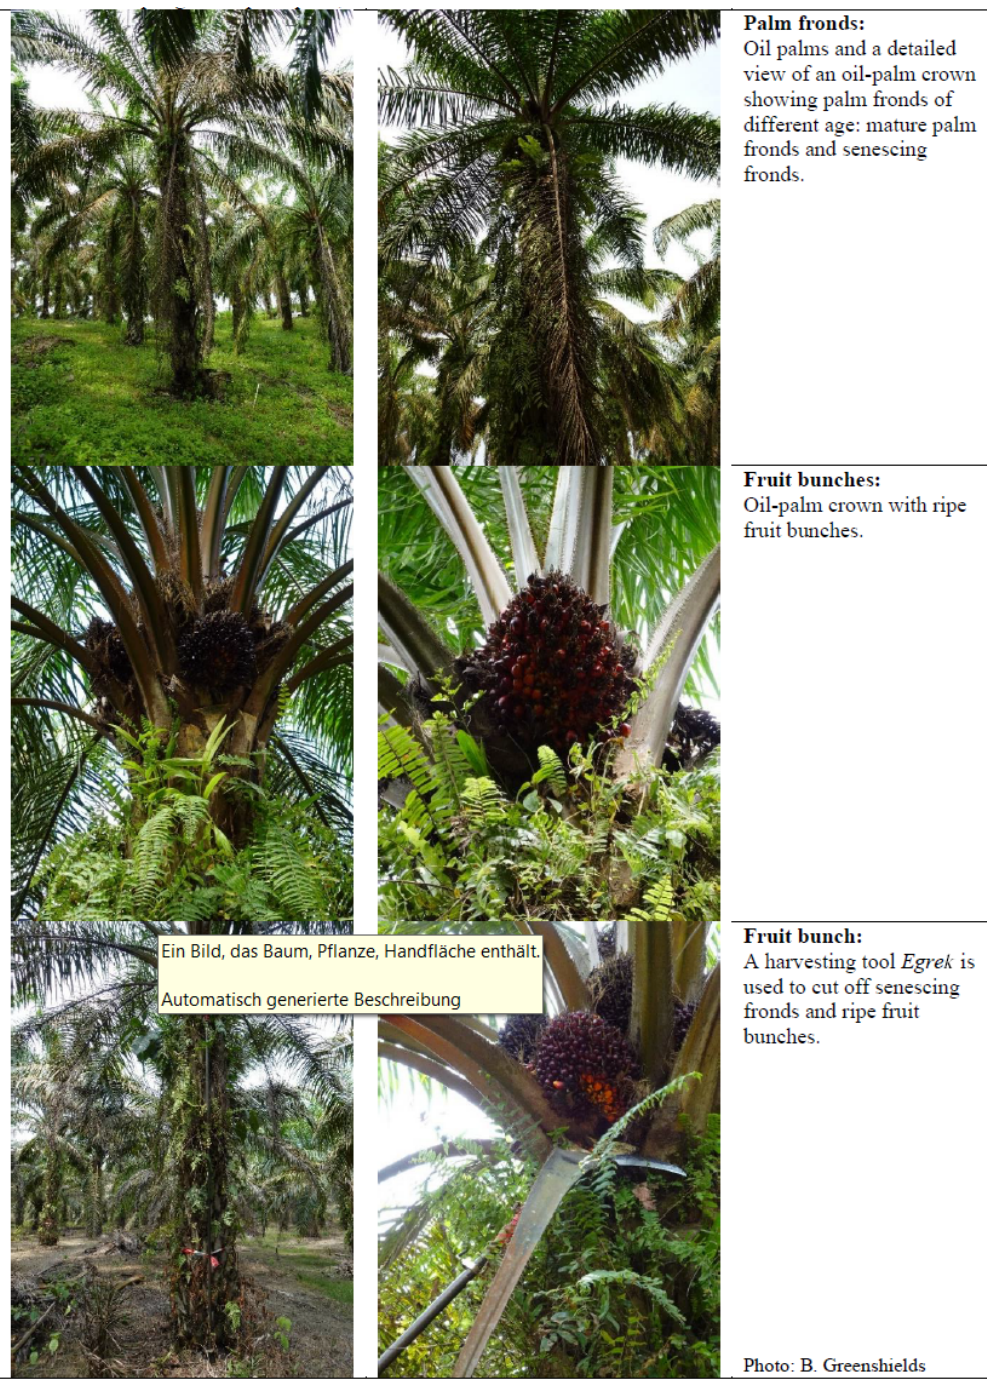
Table A1. Sampling of oil-palm parts, fieldwork